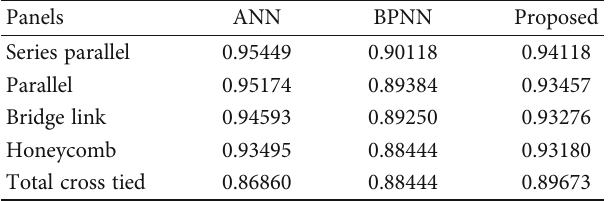
Table 4: F-measure.